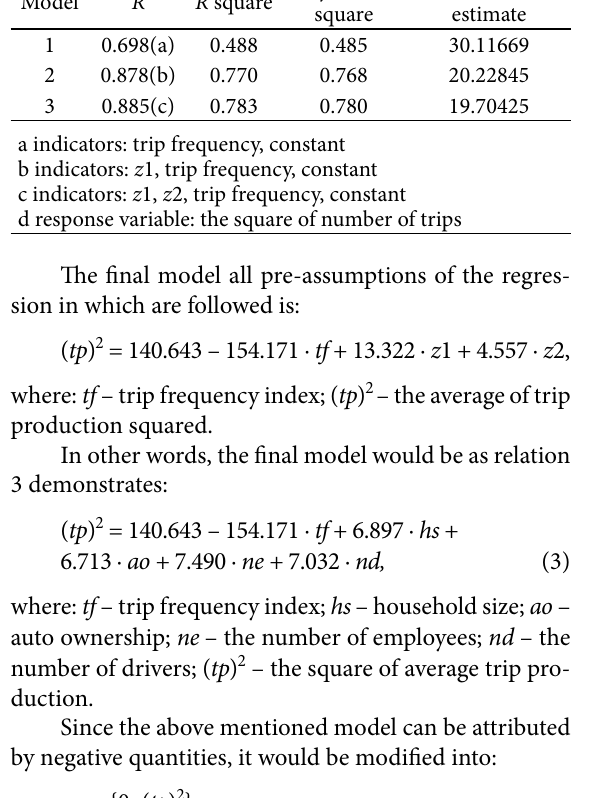
Adjusted R Std. error of the square estimate